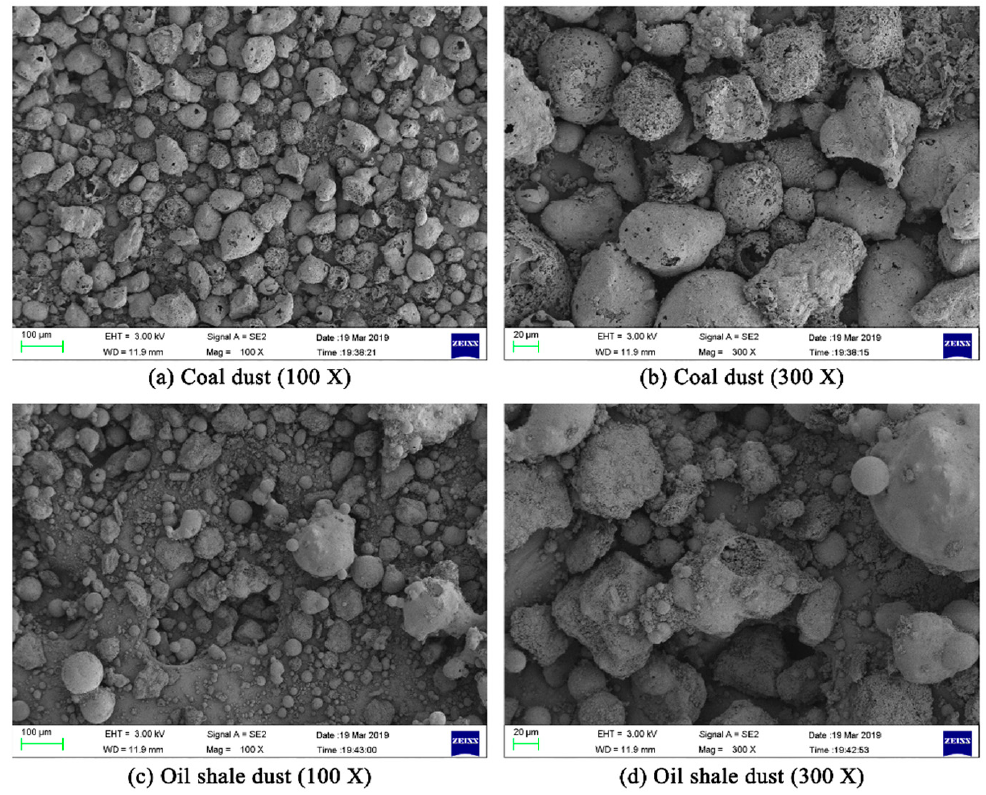
Figure 10. SEM images of dust after explosion: ( a ) coal dust (100 X); ( b ) coal dust (300 X); ( c ) oil shale dust (100 X); ( d ) oil shale dust (300 X).